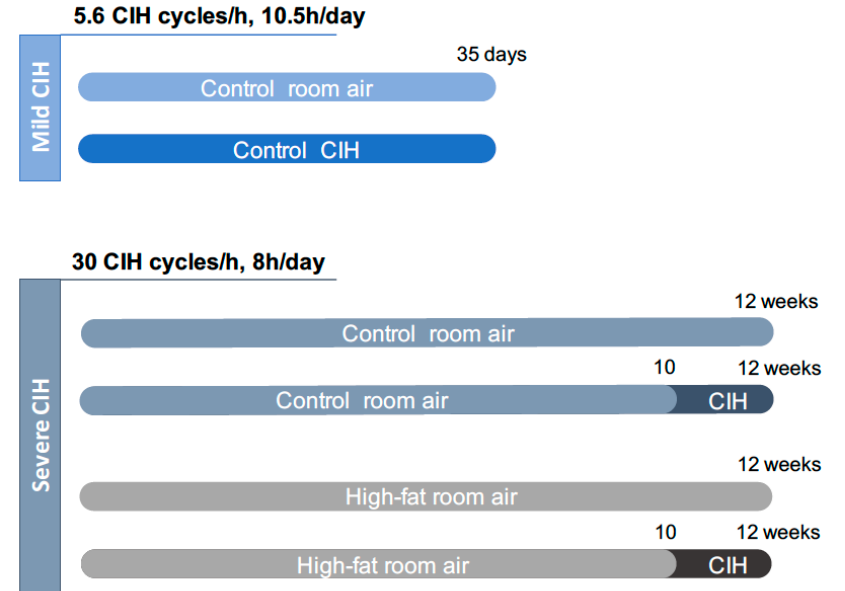
Figure 1. Experimental design of the study. The mild chronic intermittent hypoxia (CIH) paradigm consisted of 5.6 CIH cycles/h, 10.5 h/day, and it was performed in control animals (2.56 Kcal/g) during 35 days. The severe CIH paradigm consisted of 30 CIH cycles/h, 8 h/day, and it was performed in control and high-fat animals (5.1 Kcal/g) in the last 14 days of the diets, from weeks 10 to 12. Age-matched control or high-fat animals were exposed to circulating room air (21% O 2 and 79% N 2 ), in the same room and during the same time as the CIH animals to experience similar conditions.